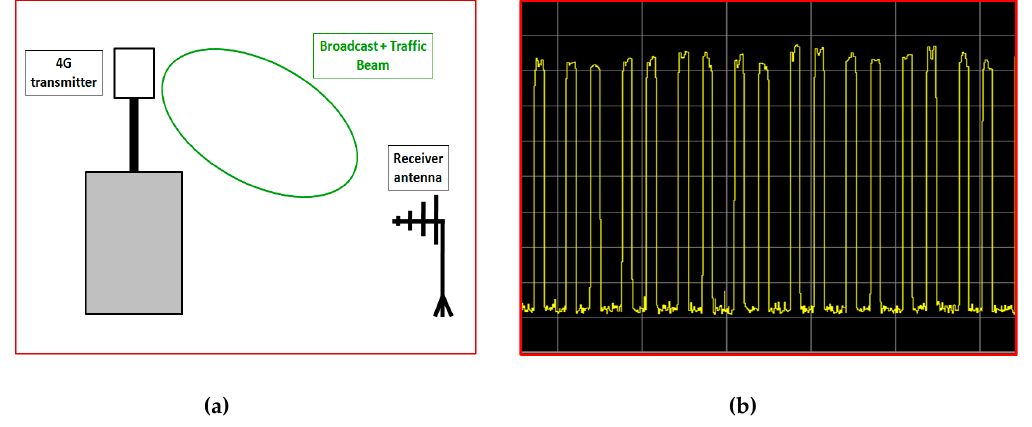
Figure 2. Static beam synthesized by a 4G passive antenna ( a ) and zero span measurement of the Cell-Specific Reference Signal (CRS) received power level ( b ). Due to the static nature of the radiation pattern, the CRS received power level is almost constant in time.